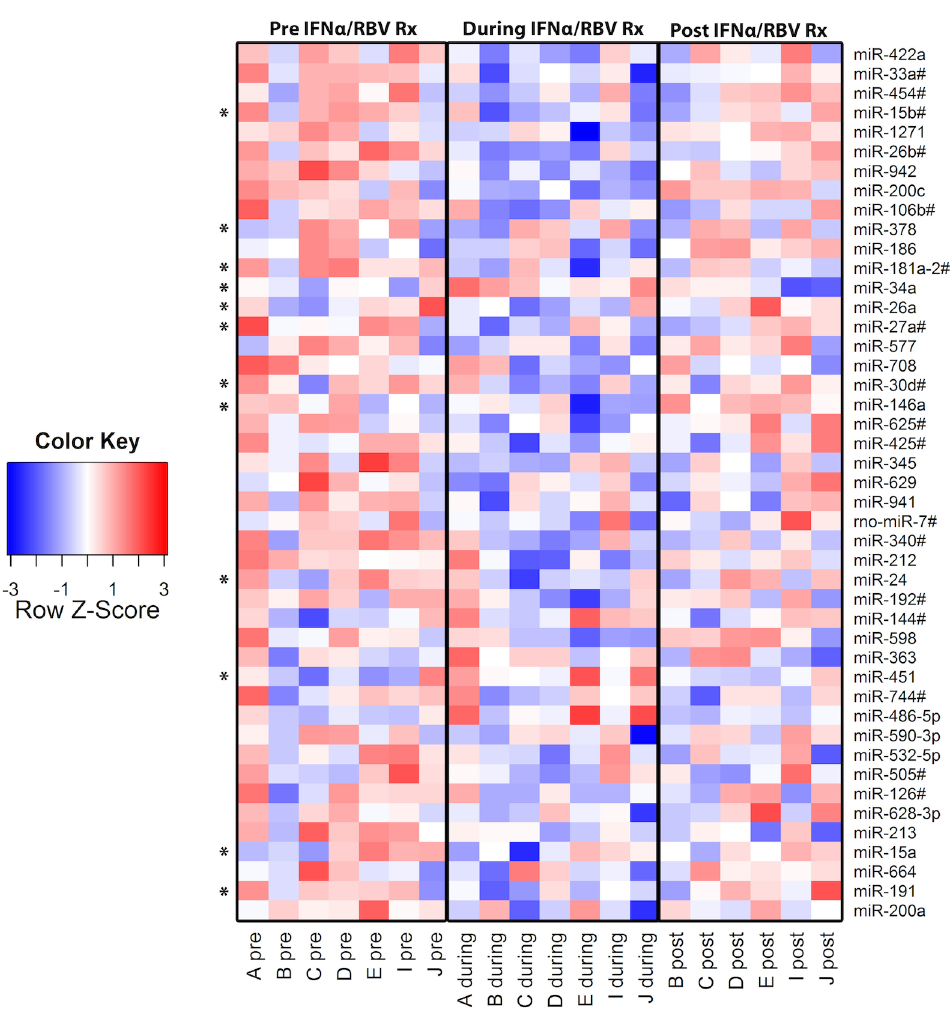
Figure 1. Heat map representing effects of IFN- a /RBV treatment on the expression of individual miRNAs. 45 miRNAs were significantly modulated by IFN- a /RBV in vivo , based on a paired t test and an uncorrected significance cutoff of p , 0.05. Relative copy numbers of each miRNA are reported. Blue color indicates #2 3 SD from the mean, red indicates $ 3 SD from the mean, and white represents the mean. Asterisks indicate previously established association with HIV-1.